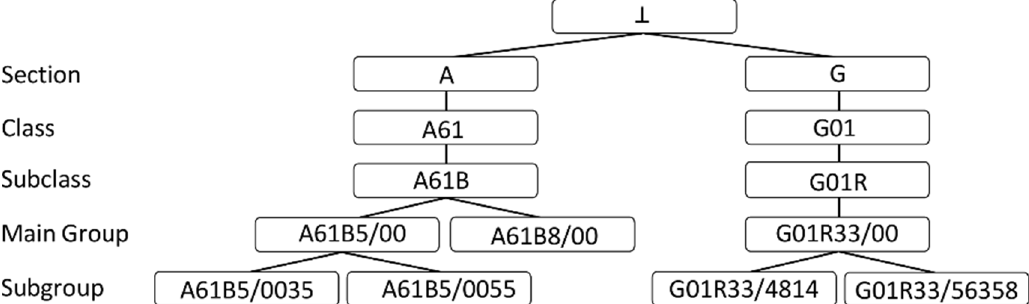
Figure 3. Example of a simplified Cooperative Patent Classification (CPC) tree of a patent parsed from the CPC code strings Scheme 2. (see also Table